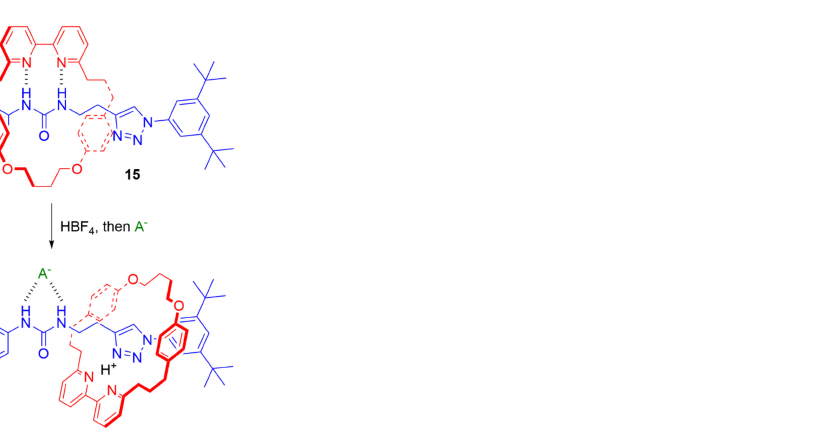
Figure 11. Revealing of anion binding site by proton induced shuttling in Goldup and Joliffe’s urea containing active template metallated rotaxane 15 .